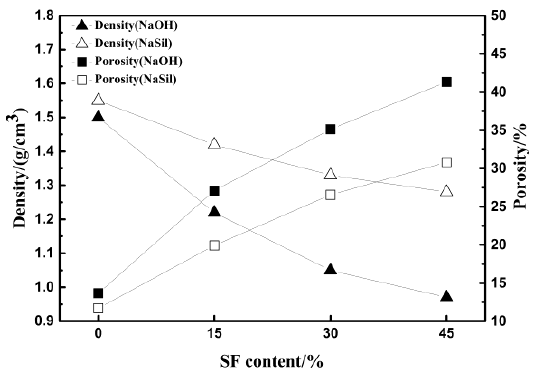
Figure 5. Density and porosity of geopolymers versus SF content.